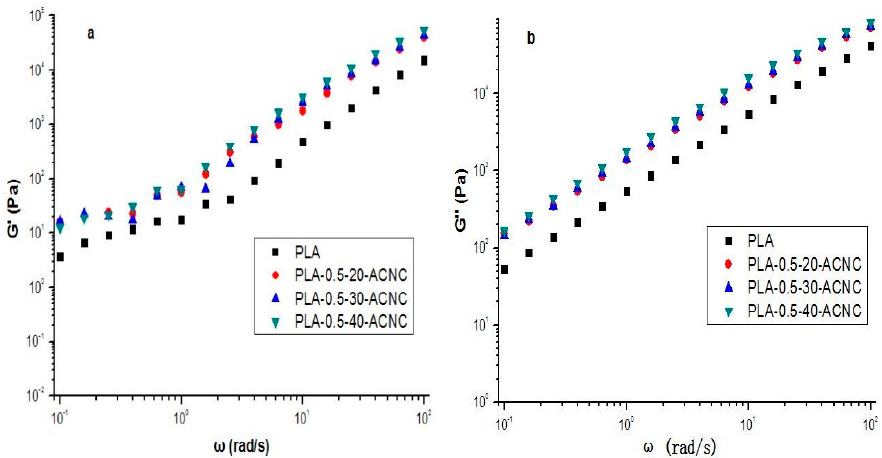
Figure 6. Storage ( G ′ ) and loss ( G ′′ ) modulus of polylactic acid (PLA)/ACNC composite films: ( a ) Storage modulus. ( b ) Loss modulus.